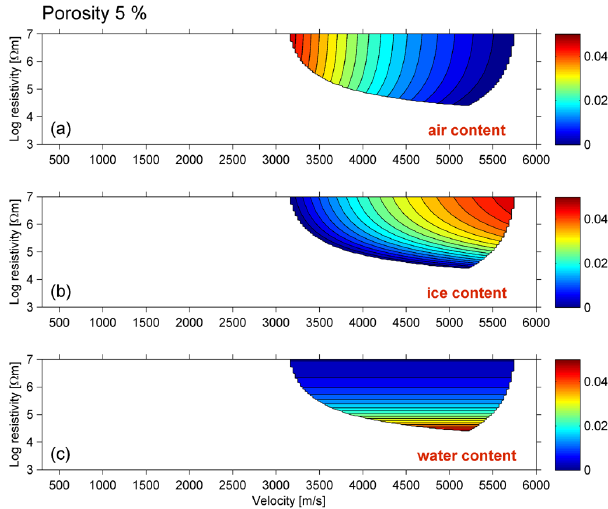
Fig. 2. As in Fig. 1, but for a porosity of 5%.